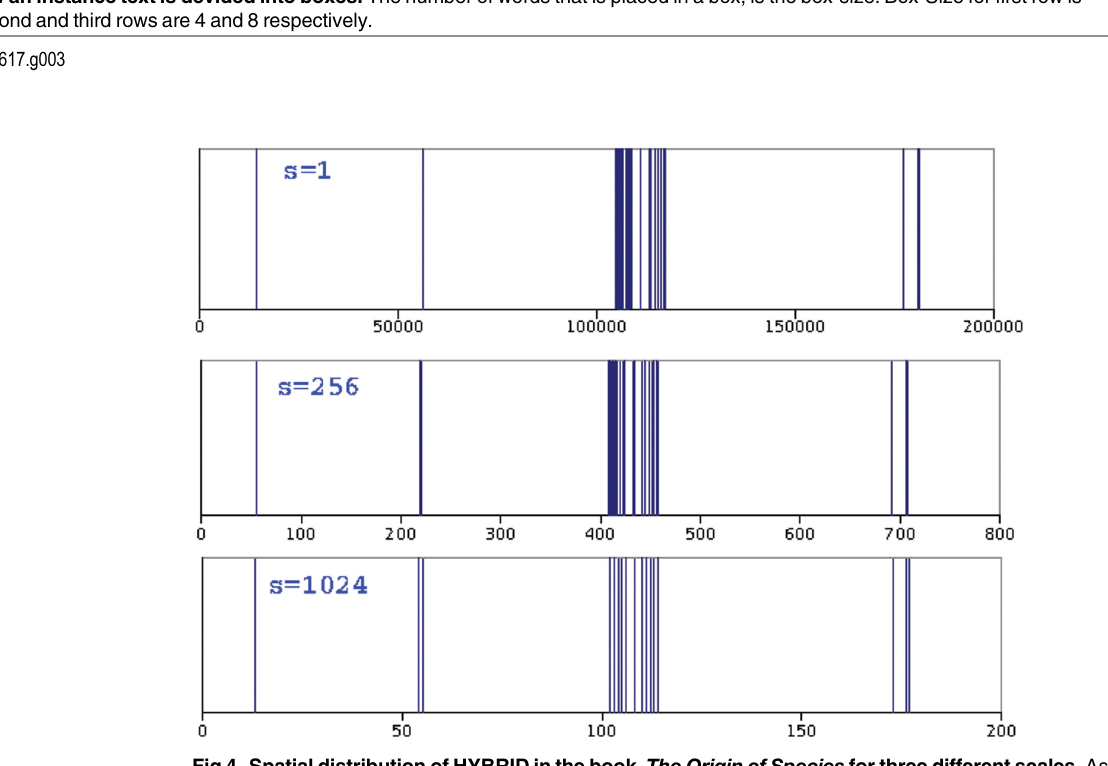
Fig 4. Spatial distribution of HYBRID in the book, The Origin of Species for three different scales. As seen, distributions in all scales, s = 1, s = 256 and s = 1024, are statistically the same. They have similar